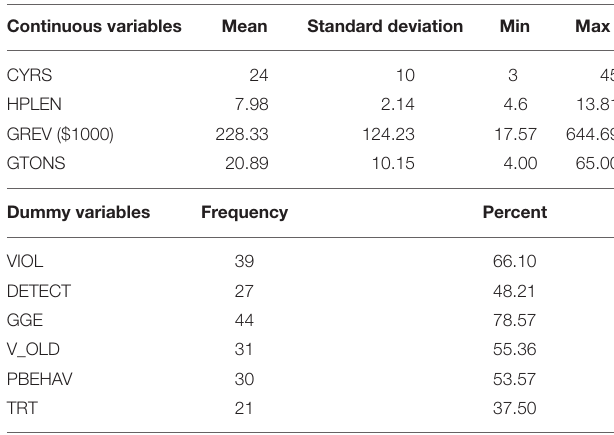
TABLE 2 | Summary statistics and frequency distribution of the independent variables.